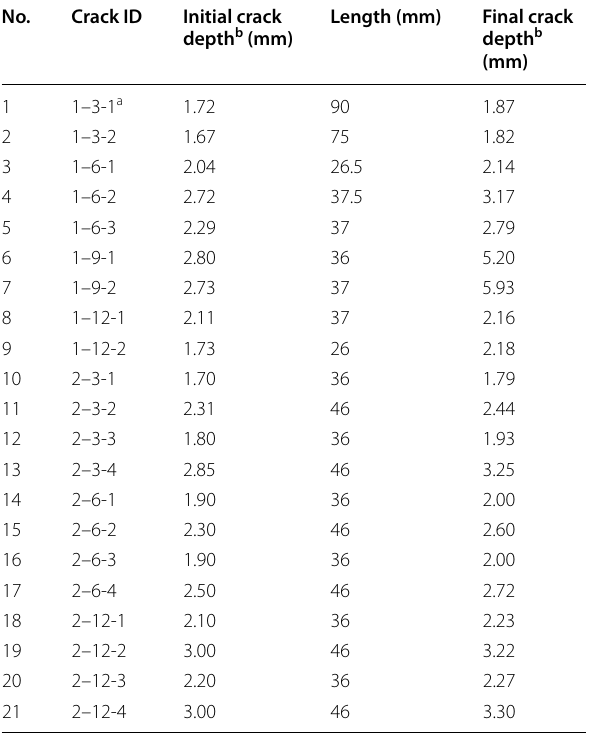
Table 1 Depths and lengths of 21 cracks used to evaluate the accuracy of the growth models